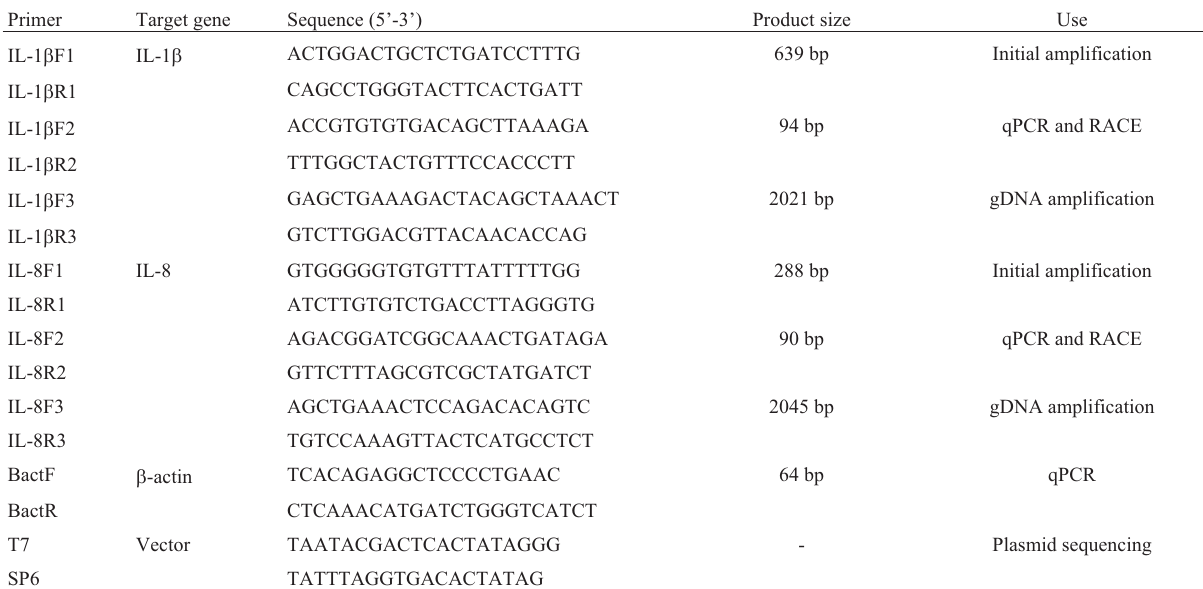
Table 1 - Primers used for P. mesopotamicus IL-1 (cid:2) and IL-8 cloning and expression analysis.